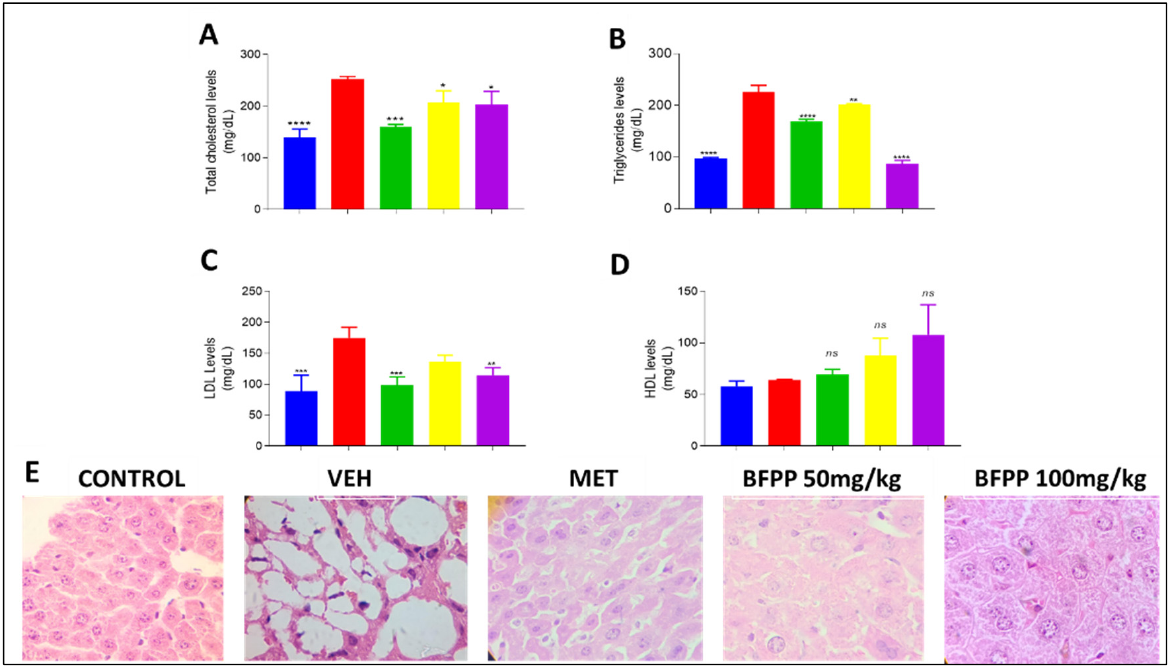
Figure 5. Effect of BFPP on lipid profile parameters. Normoglycemic (blue), vehicle (red), metformin 250 mg/kg (green), BPFF 50 mg/kg (yellow), BFPP 100 mg/kg (purple). The data are expressed as mean ± SEM n = 6 animals per group. One-way ANOVA post-test Dunnet; ns : not significant;* p ≤ 0.05; ** p ≤ 0.01, *** p < 0.001 and **** p ≤ 0.0001 with respect to the vehicle group. ( A ) Total cholesterol levels; ( B ) triglyceride levels; ( C ) LDL levels; ( D ) HDL levels; ( E ) Liver histology (CONTROL: Normoglycemic group; VEH: diabetic group which received only vehicle; MET: Metformin 250 mg/kg; BFPP 50 mg/kg and BFPP 100 mg/kg.